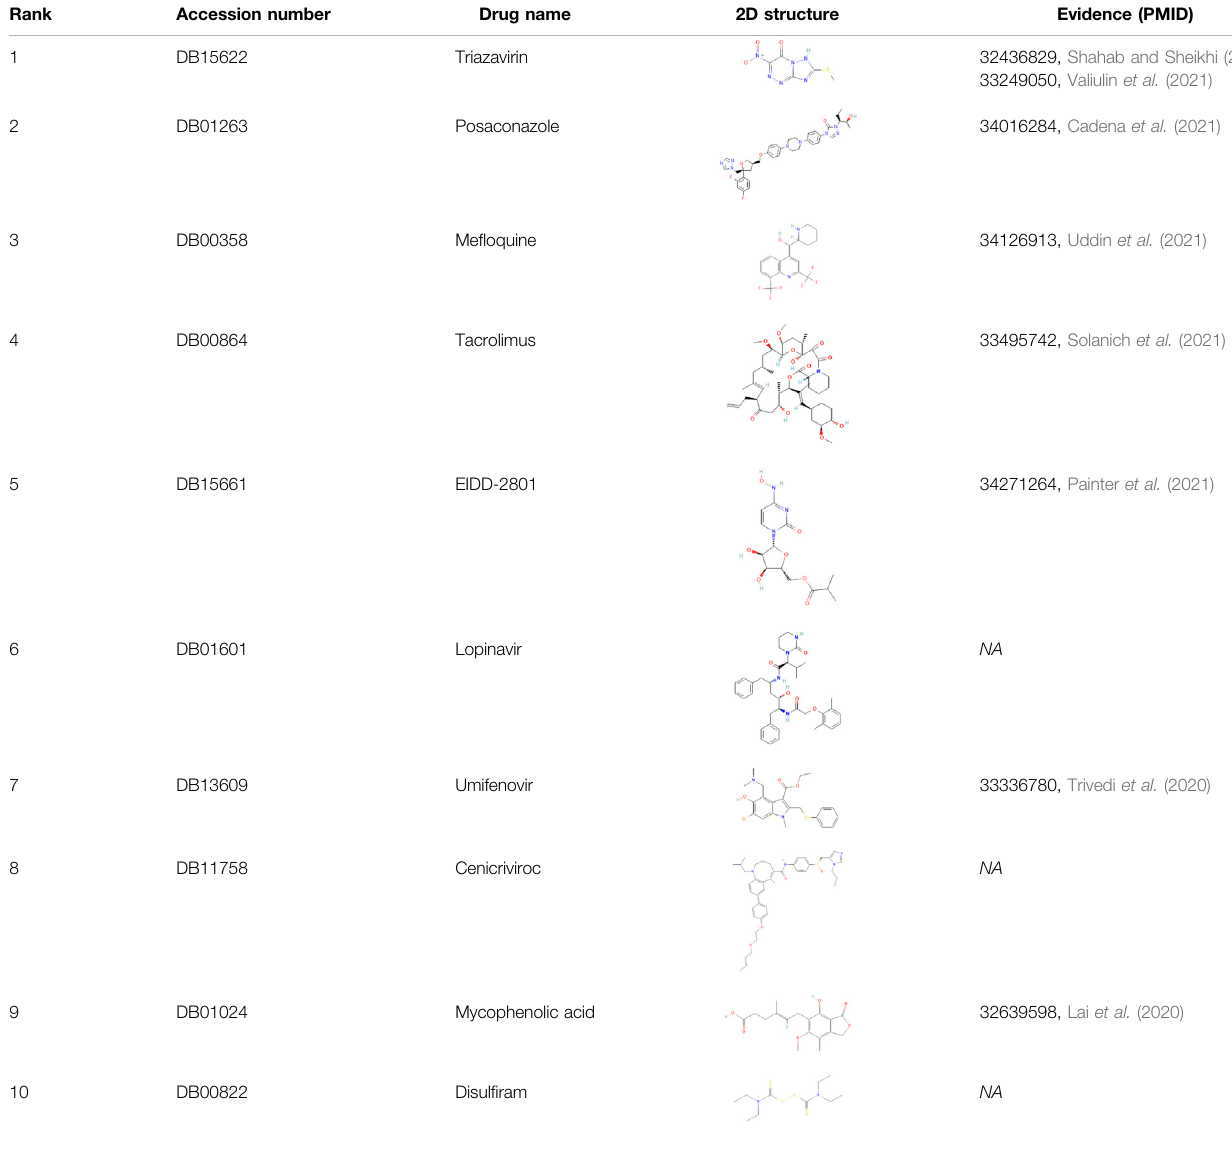
TABLE 6 | Top 10 possible anti-COVID-19 drugs predicted by the